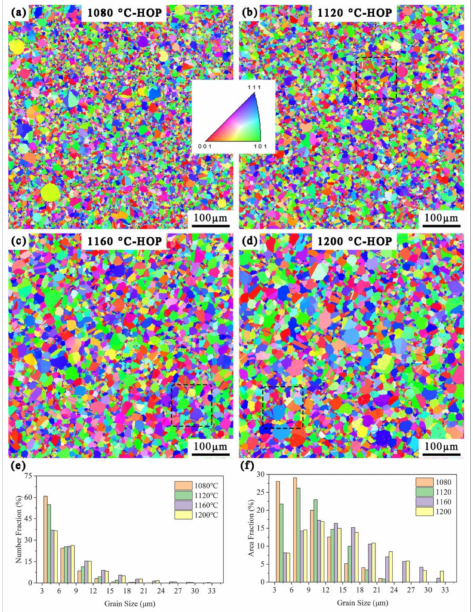
Figure 12. Inverse pole figure (IPF) of the samples: ( a ) 1080 ◦ C-HOP; ( b ) 1120 ◦ C-HOP; ( c ) 1160 ◦ C- HOP; ( d ) 1200 ◦ C-HOP; grain size distribution; ( e ) number fraction; ( f ) area